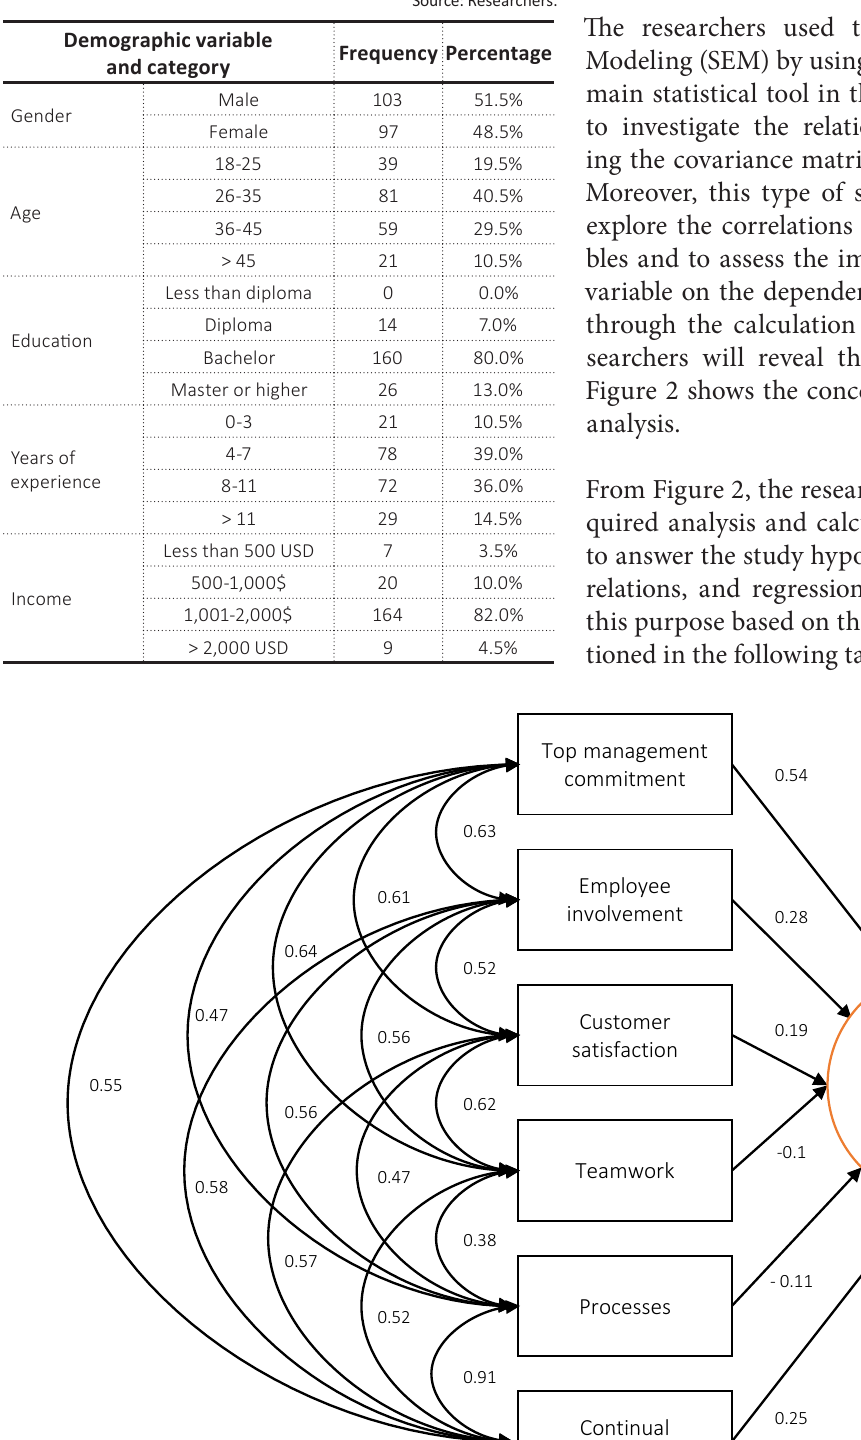
Table 8. Respondents’ characteristics